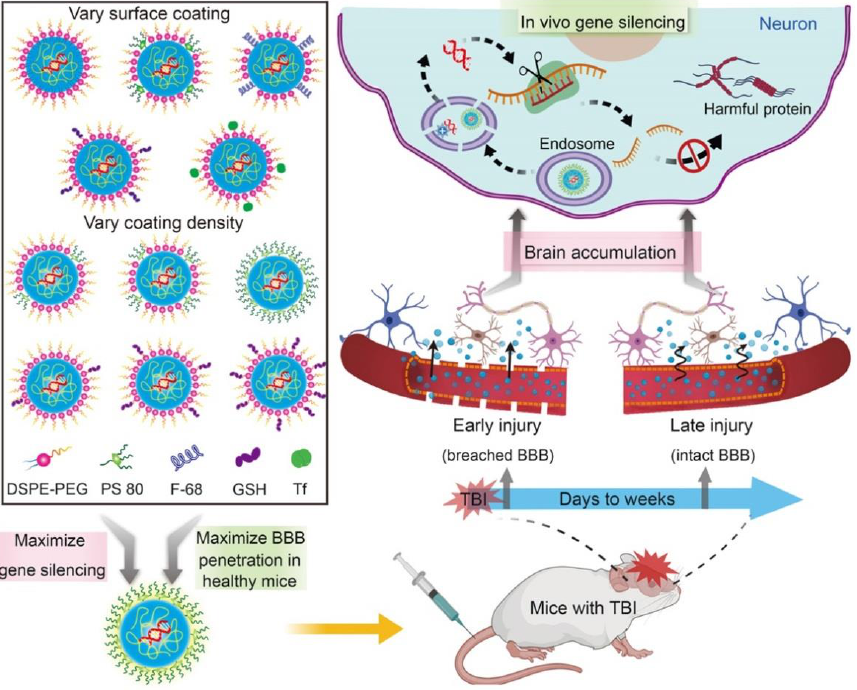
Figure 10. Schematic illustrating the design and mechanism of BBB pathophysiology –